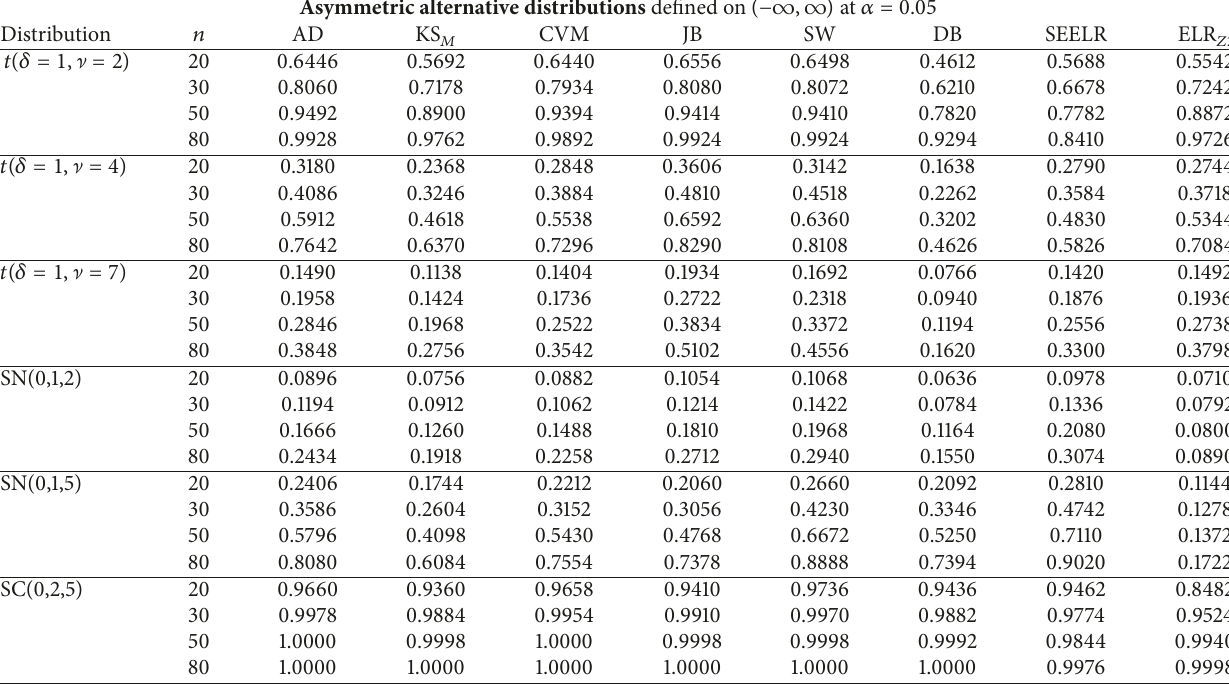
Table 8: Results of the Monte Carlo power comparisons based on samples with sizes (𝑛) from asymmetric alternative distributions defined on (−∞, ∞) at 𝛼 = 0.05